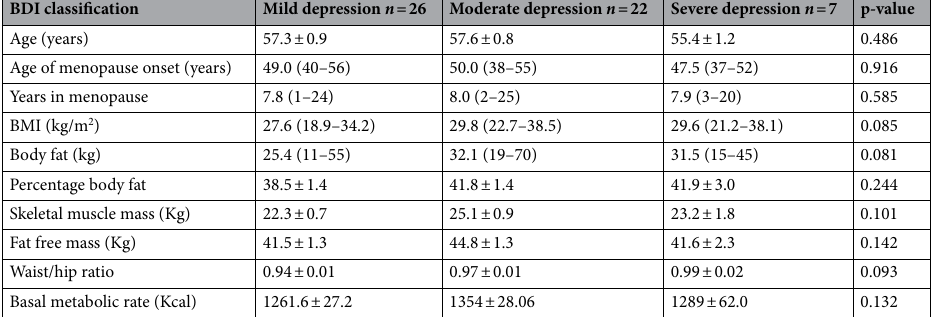
Table 2. Anthropometric characteristics. Variables with normal distribution were analyzed by ANOVA and presented as mean ± standard error. Variables not normally distributed were analyzed by Kruskall–Wallis test and presented as median